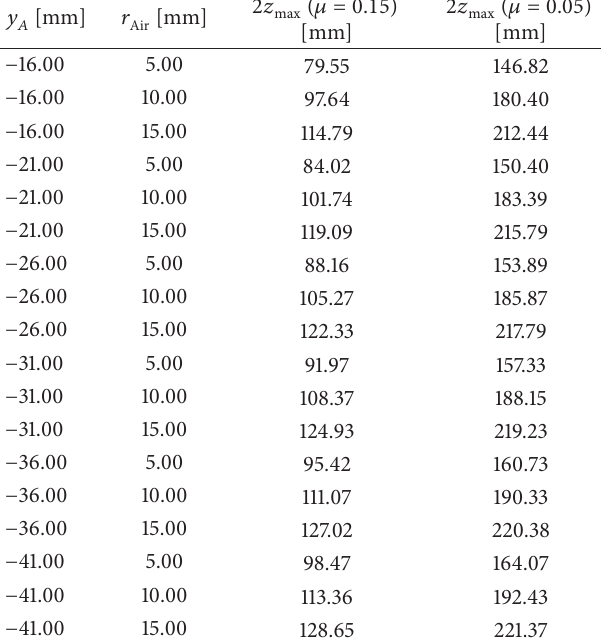
Table 3: The values of 𝑧 max . The transmittance of 10mm thick water layer is 60%.